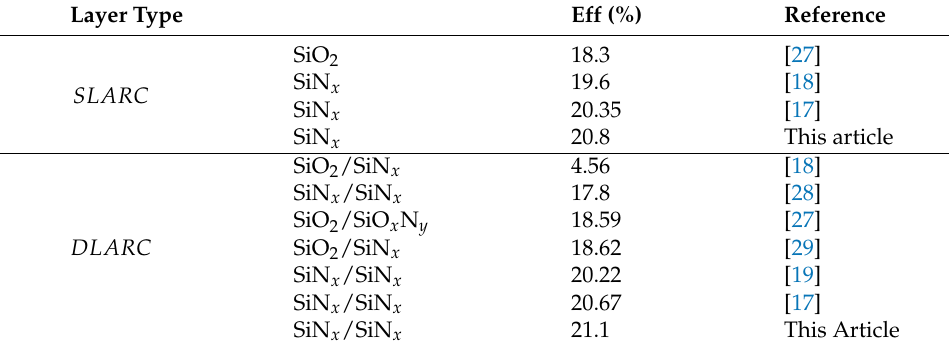
Figure 7. EQE measurement carried on single and double layer ARC layers. Inset shows the IV results obtained with the solar cell measurement. Table 4. Comparison of the I − V results obtained with different ARC